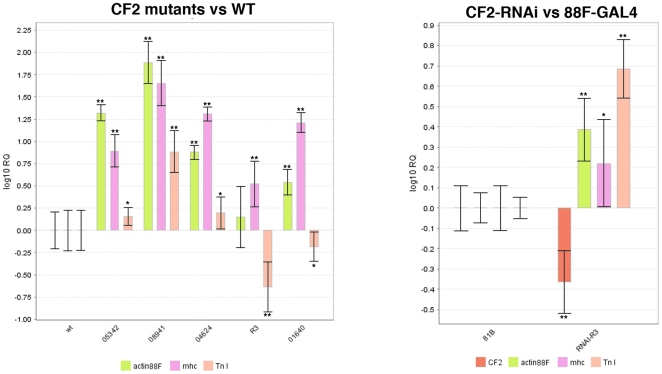
Transcription of muscle structural genes is altered in CF2 loss of function mutants.Graphs of a representative qPCR run from A) Five different CF2 mutant lines tested against a wild type strain, B) 88F-GAL4[81B-13]/+;11924-R3 CF2-RNAi/+ tested against 88F-GAL4[81B-13]/SM6. ** denotes differences from the control with a P-value ≤0.001. * denotes a P-value <0.05.